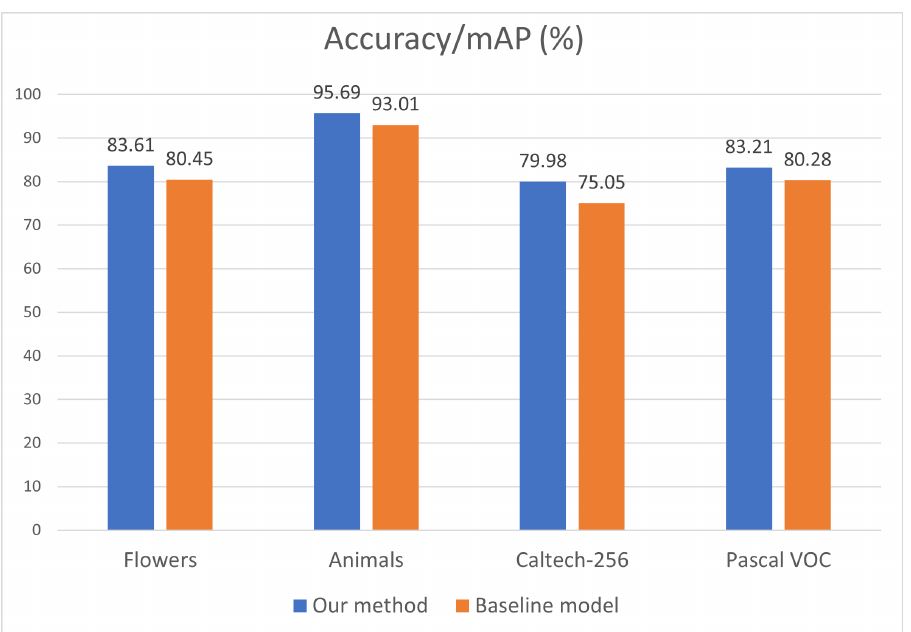
Figure 6. Result comparison on flowers, animals, and categories of living beings (animals, birds, insects, persons) from the Caltech-256 dataset and natural scenes (plants, flowers) from the Pascal VOC 2007